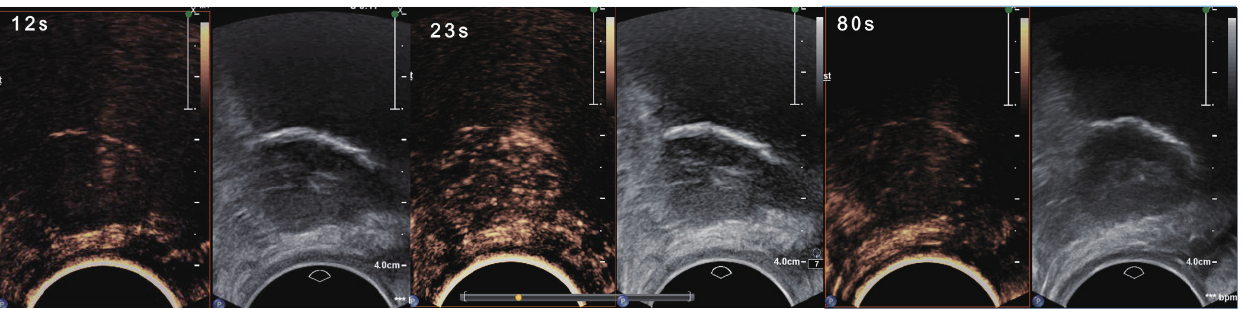
Figure 2 CEUS displayed ring-enhancement at the very beginning (12s), then appeared isovascular and homogeneous enhancement. It was obiviously encapsulated during the arterial and venous phase.